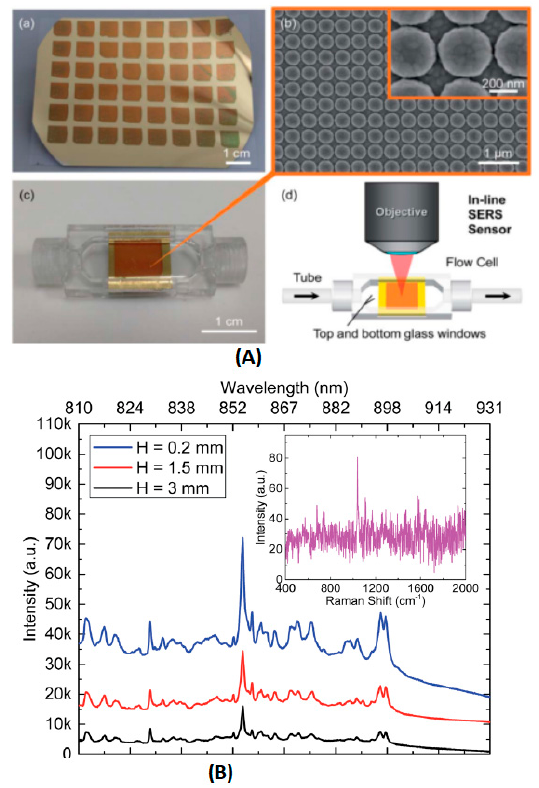
Figure 7. ( A ) ( a ) Image of the PNA surface fabricated on a flexible polymer sheet. ( b ) SEM image of the completed PNA surface. Inset: close-up SEM image of the PNA surface, with a measured inter-dome separation distance of 15-20 nm. ( c ) Image of the SERS sensor, assembled by the incorporation of the flexible PNA substrate into a plastic flow cell. ( d ) Schematic of an in-line SERS sensor, where two cylindrical openings at the ends of the SERS sensor are connected in a series with biomedical tubing and a 785 nm laser, focused on the PNA surface by a 50 objective. ( B ) SERS spectra of 25 mg mL − 1 promethazine solution for SERS sensors with varying chamber heights (H). Primary SERS intensity peak for promethazine can be observed at 1037 cm − 1 . The inset represents the Raman spectrum of 25 mg mL − 1 promethazine solution, acquired when the laser was focused on a uniform non-nanostructured gold surface. (by H. Y. Wu [103]).